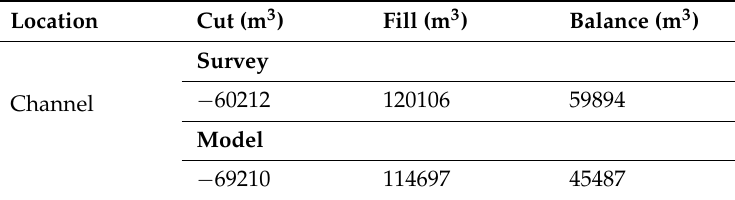
Table 4. Volume comparison of morphodynamic simulations.